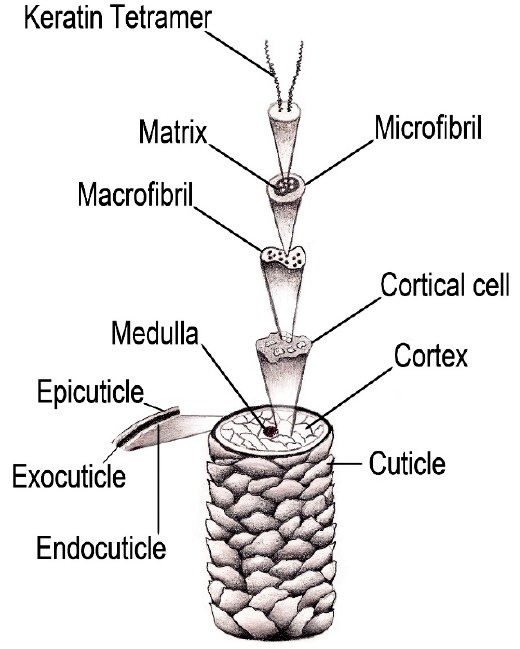
Figure 1. The hierarchical structure of hair.